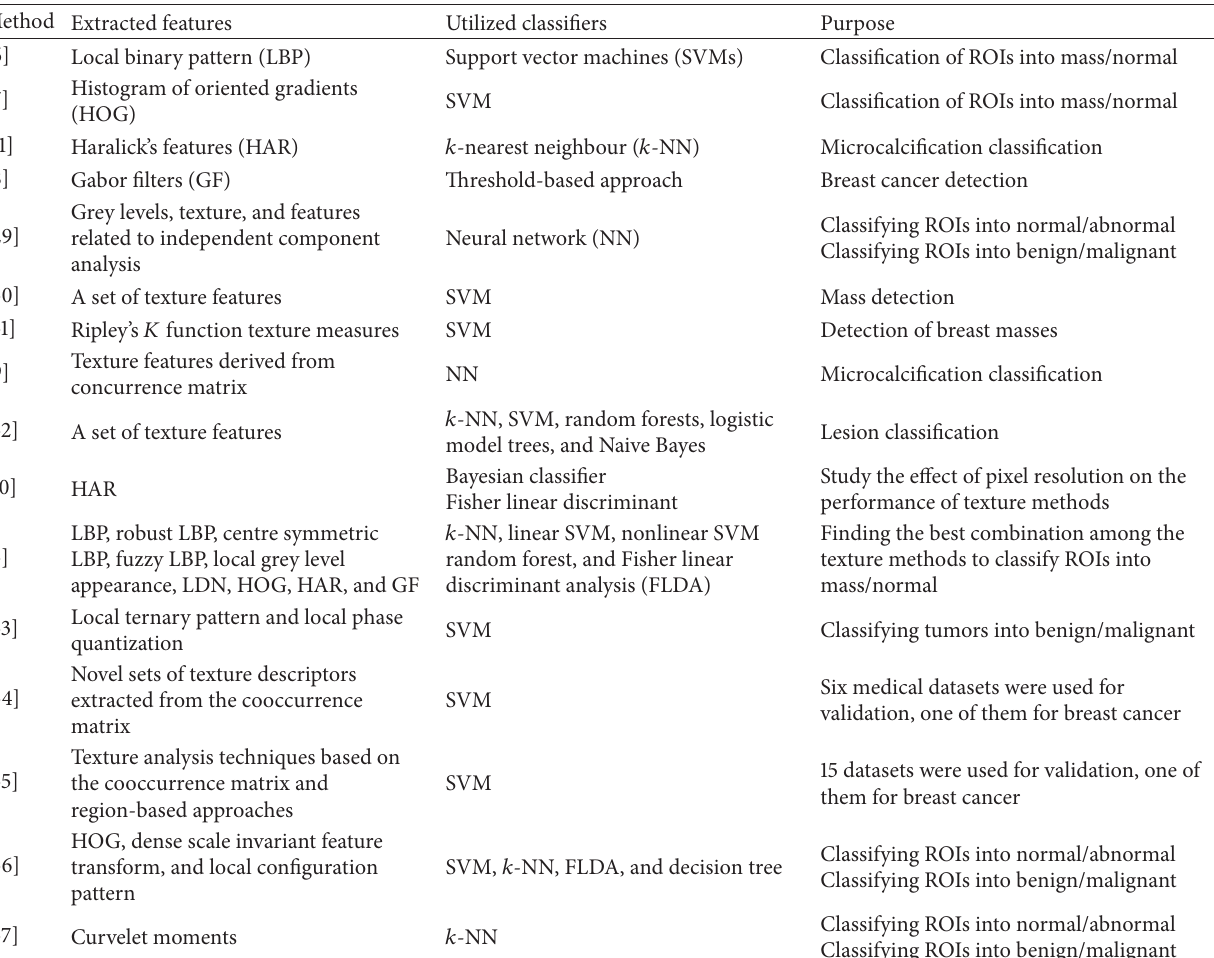
Table 1: Summary of texture analysis methods that have been used to analyze